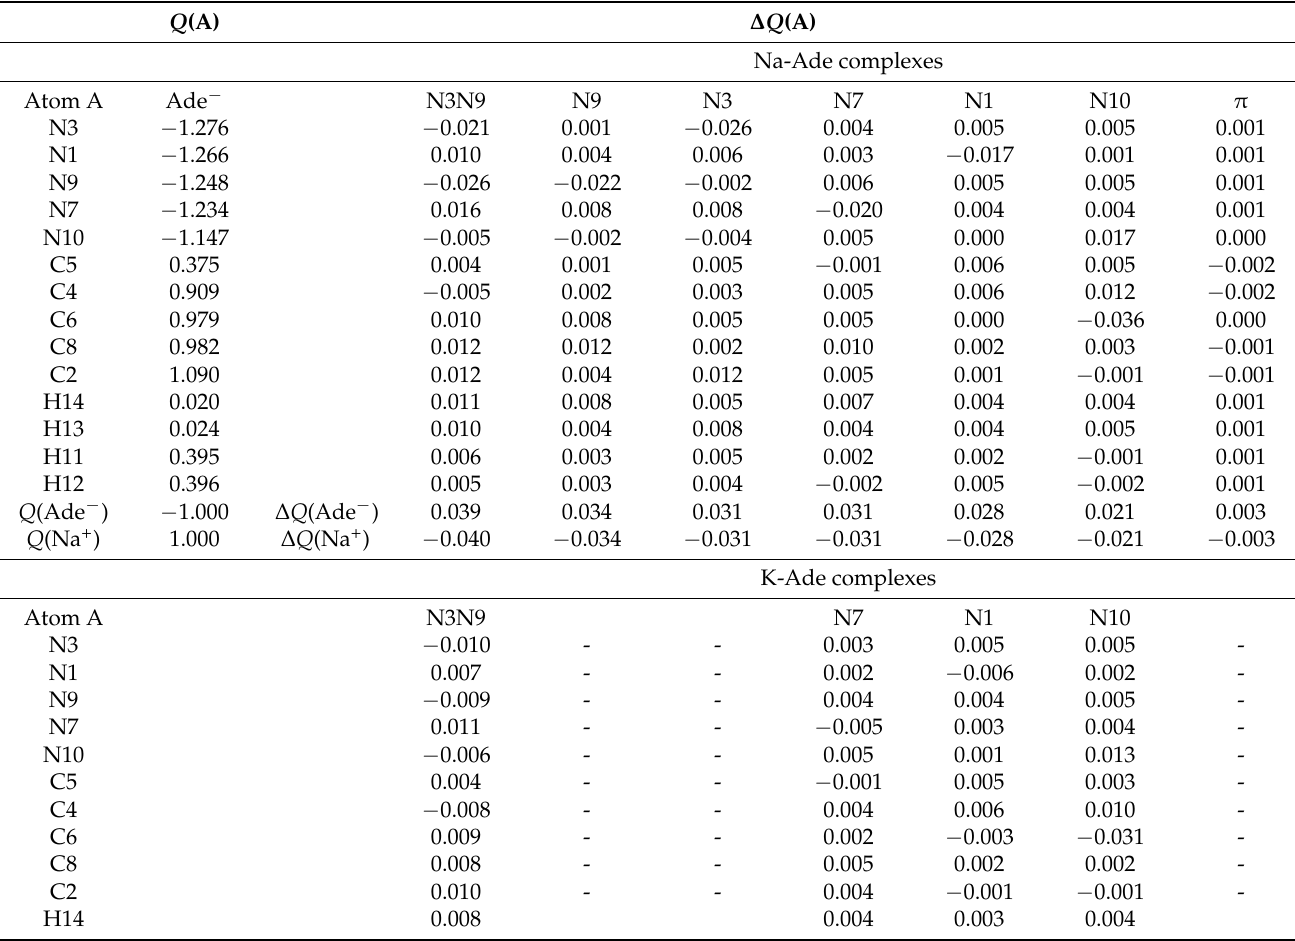
Table 4. The net atomic charges of the atoms Q (A) of free Ade − , the net molecular charge of Ade − Q (Ade − ), and counter ions Q (Na + ) and Q (K + ). Relative to free ions, changes in these charges, obtained for each of the CIPs, are also included. All values are in e and are reported at the CCSD level of